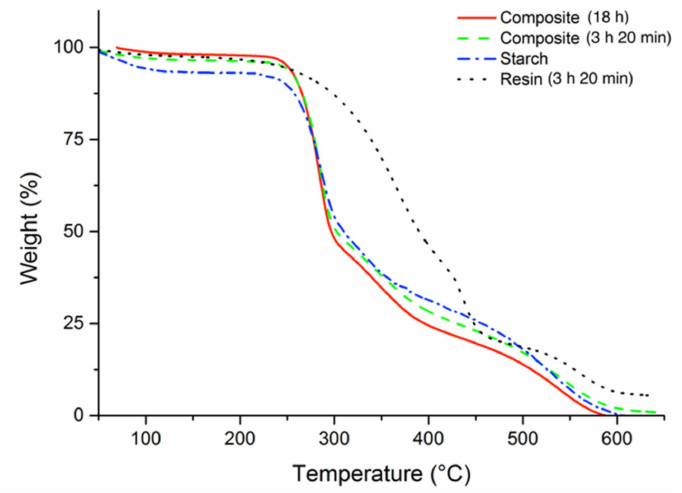
Figure 5. TGA curves of neat starch, unreinforced resin, and starch composites with composition 8, cured at 140 ◦ C for 3 h 20 min, and 18 h.